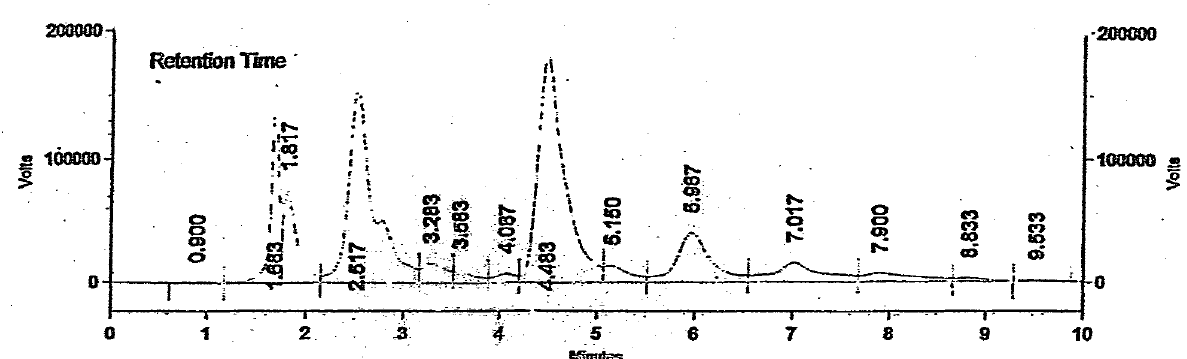
Figure 6: HPLC analysis of F1: of butanol extract of Cynaria scolymus of Pharmacy College Baghdad University. Fraction of the column № 7.